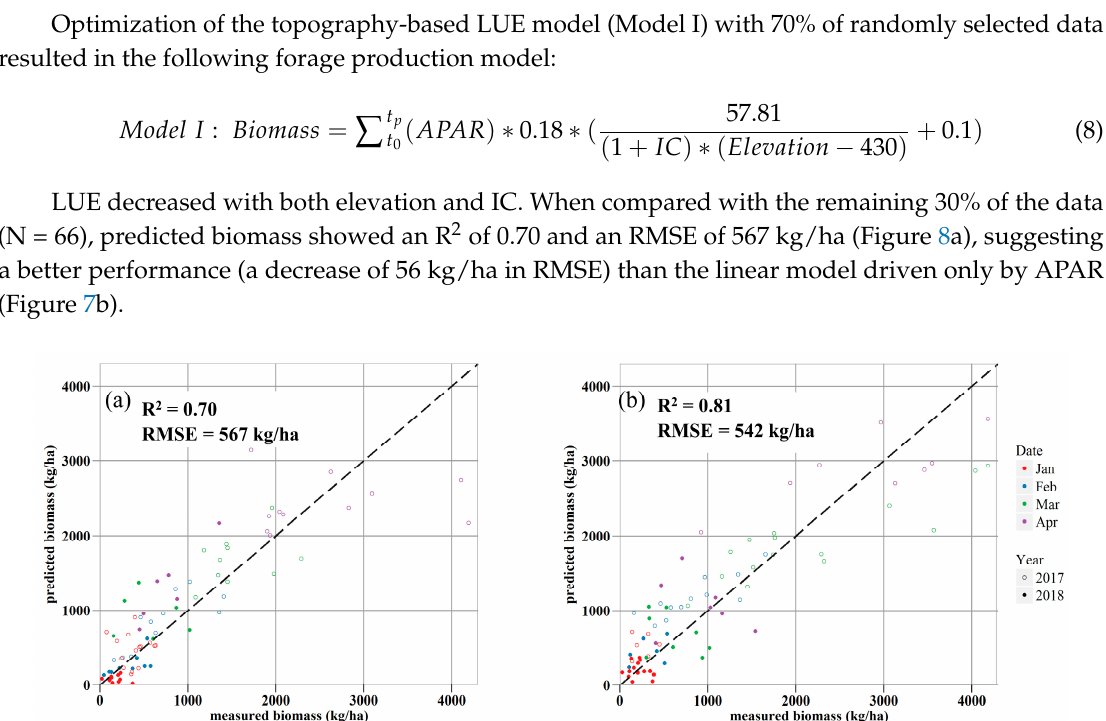
Figure 7. Scatterplots of measured biomass versus the cumulated NDVI ( a ) and cumulated APAR ( b ) over 220 clip-plot samples in 2017 and 2018.